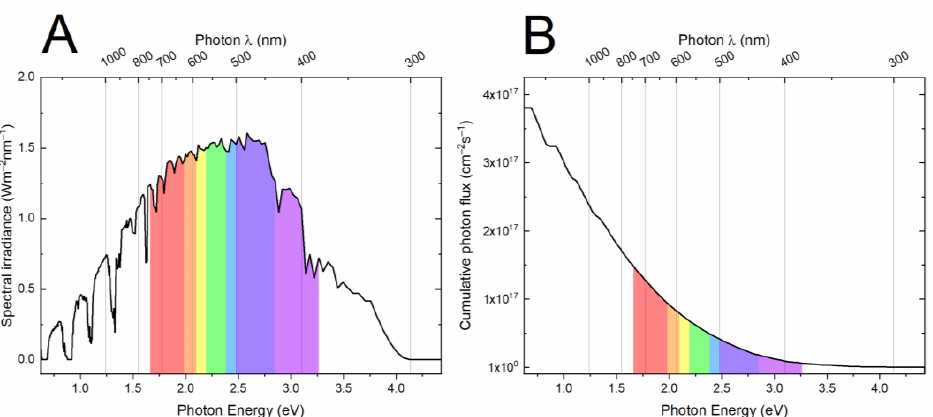
Figure 6. ( A ) Spectral irradiance. ( B ) Cumulative photon flux per photon energy (eV) and wave- length (λ). (Elaboration of data from https://www.nrel.gov/grid/solar-resource/spectra.html; source accessed on 04/04/2022).